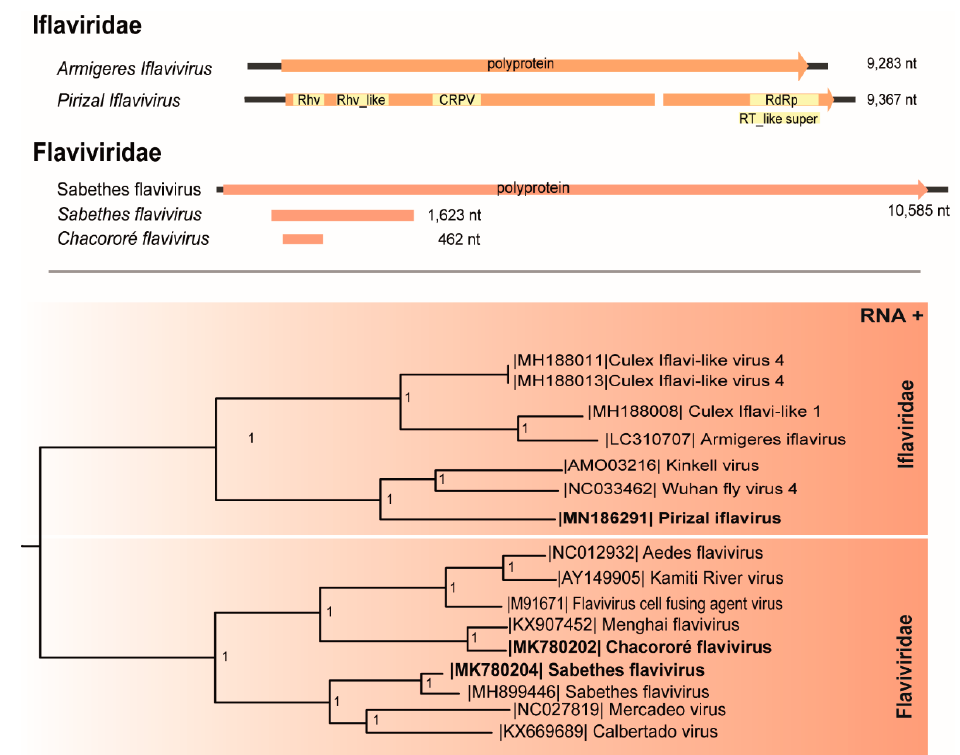
Figure 2. Genome map and maximum likelihood phylogenetic tree of Pirizal iflavirus, Chacororé flavivirus, and Sabethes flavivirus members of the Iflaviridae and Flaviviridae family, respectively. The length of each branch represents the expected number of amino acid substitutions per site.